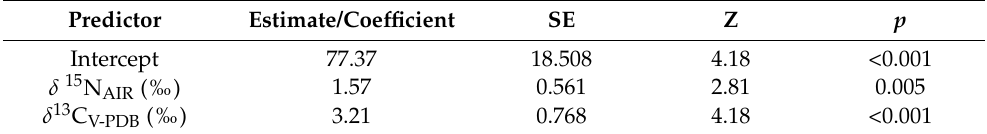
Table 3. Binomial logistic regression model and its coefficients. Predictor Estimate/Coefficient SE Z p Intercept 77.37